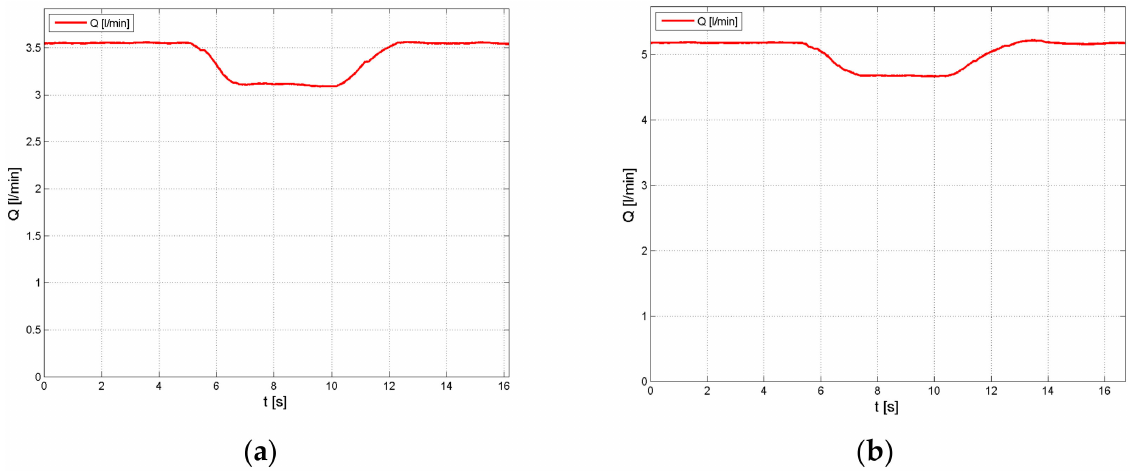
Figure 19. Waveforms of the pump flow rate (Q) for the speed of: ( a ) 1000 rpm; ( b ) 1500 rpm.